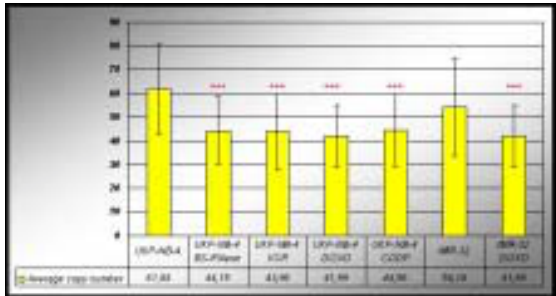
Fig. 1. Average number of the MYCN gene copies This decrease seems to be related to the sensitivity of the used drug. MYCN amplification is formed in the early stage of tumour development and there aren’t any reported changes in amplification in the further development of the disease. We used real-time RT-PCR for determination of the relative expression of mRNA MYCN. In parental cell lines, there is more than 2 logs higher expression than in healthy volunteer leukocytes. In all drug-resistant cell lines, the expression is approximately more than one log higher in comparison to the parental cell lines (Fig. 2).